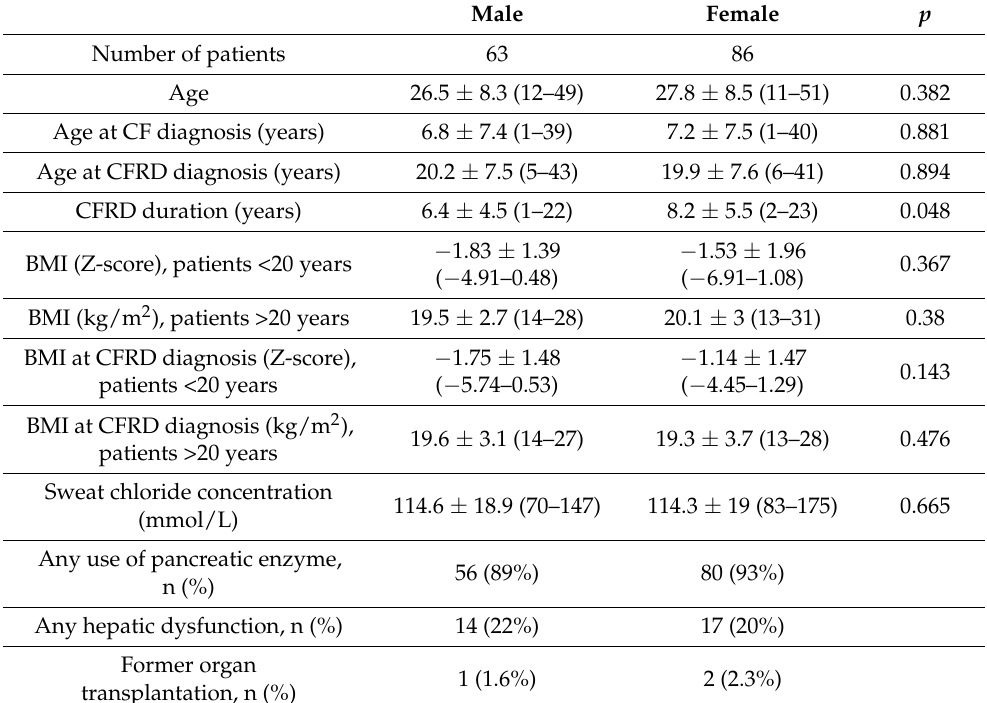
Table 1. Demographic characteristics of patients with CFRD at the time of the study and at the diagnosis of CFRD; p value was determined by Mann–Whitney U test